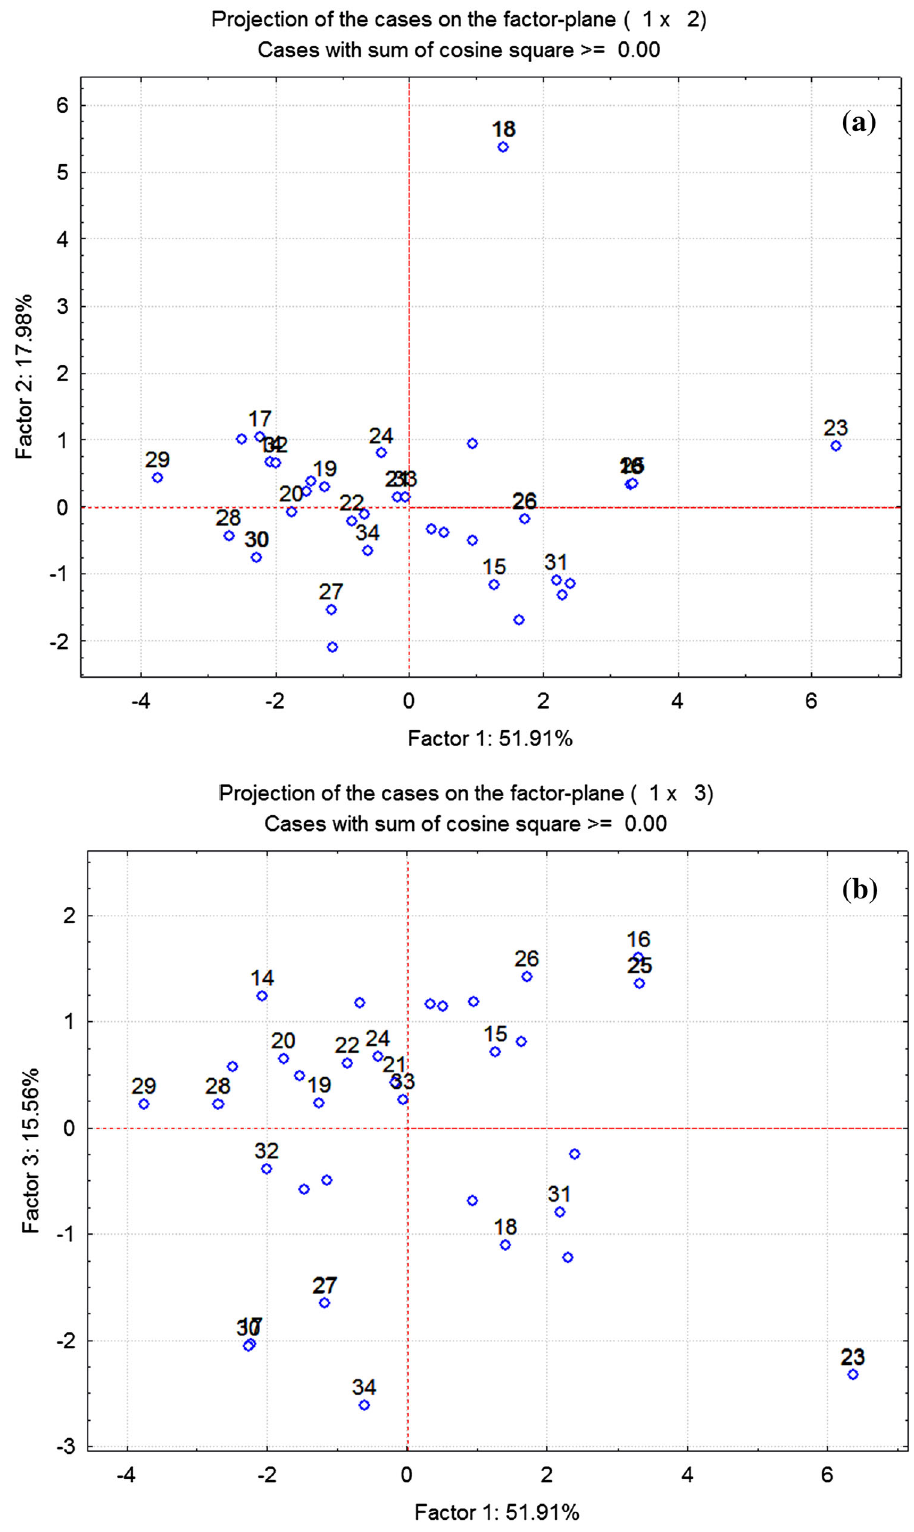
Fig. 11 Spatial distribution of the individuals in the axes system a F1-F2 and